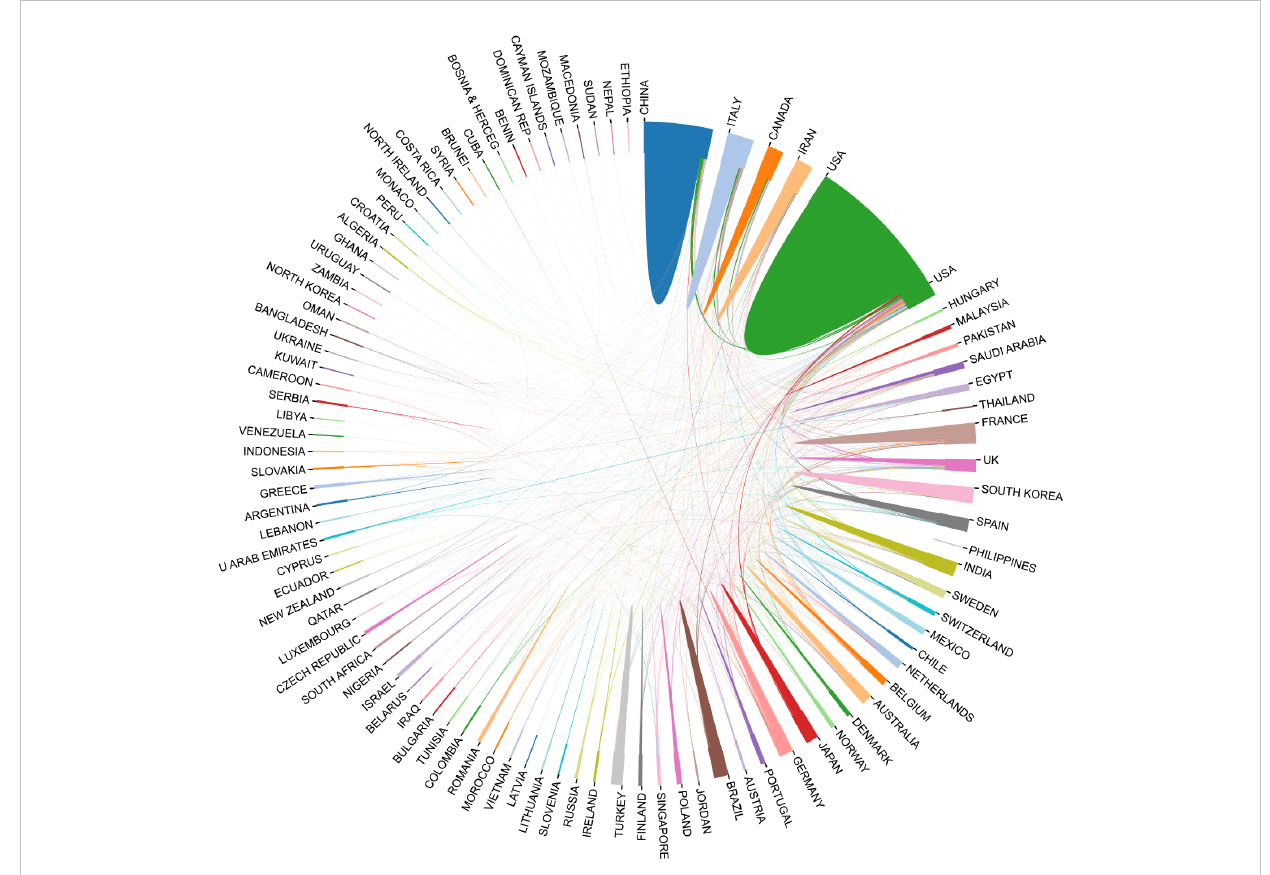
FIGURE 3 International collaboration in breast cancer in fl ammation research from 2013 to